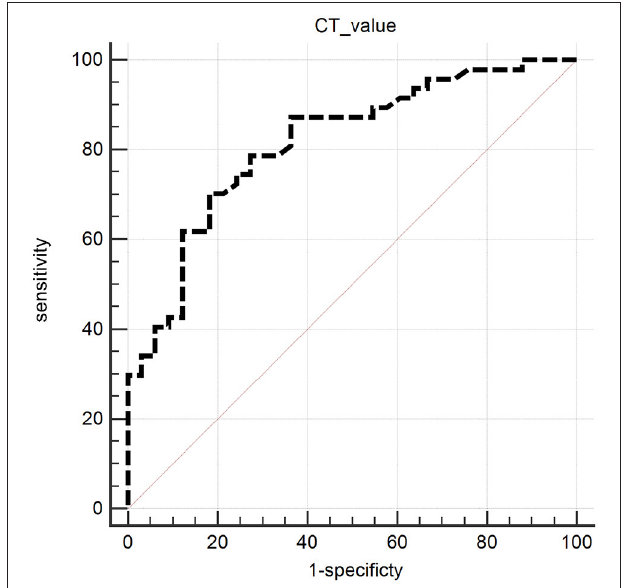
FIGURE 3 | ROC curve analysis of the highest CT value in HALs territory to predict IH. The highest CT value in HALs was a predictive factor for IH with the area under curve (AUC) of 0.816 (95% confidence interval [CI] 0.713–0.894, p < 0.001). ROC, receiver-operating characteristic.